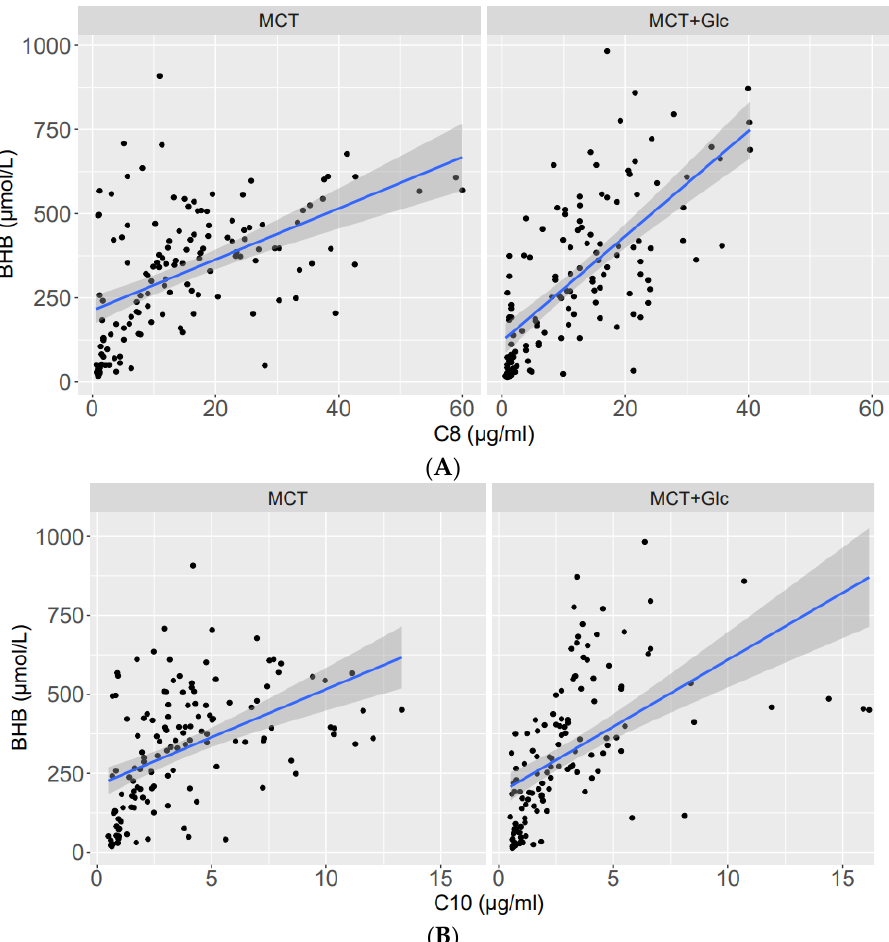
Figure 8. ( A ): C8—related plasma BHB levels with MCT ( left ) and MCT plus glucose ( right ). The indicated line represents the best fit of a linear regression with plasma C8 ( µ g/mL). ( B ) : C10—related plasma BHB levels with MCT ( left ) and MCT plus glucose ( right ). The indicated line represents the best fit of a linear regression with plasma C10 ( µ